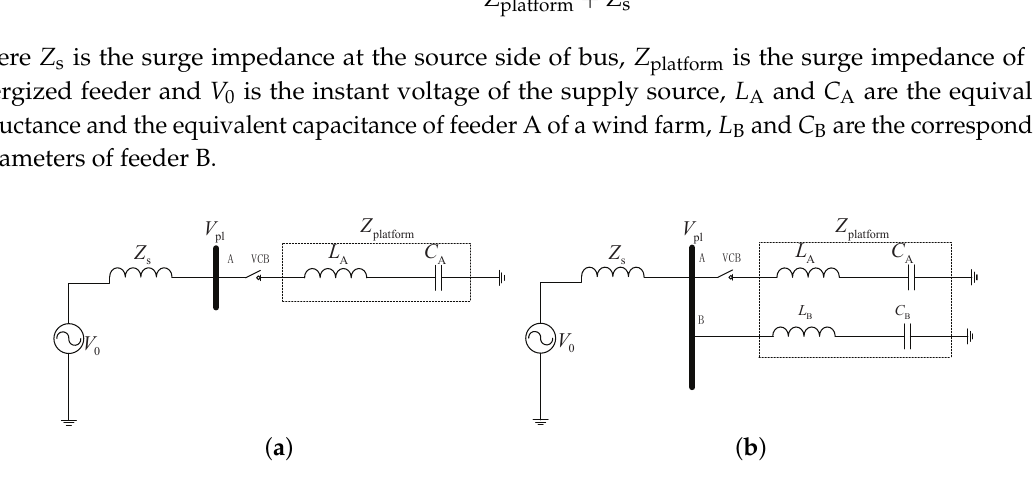
Figure 9. Simplified schematic for energizing one feeder with different connected feeder number: ( a ) simplified schematic for energizing one feeder without any feeder connected; and ( b ) simplified schematic for energizing one feeder with another feeder